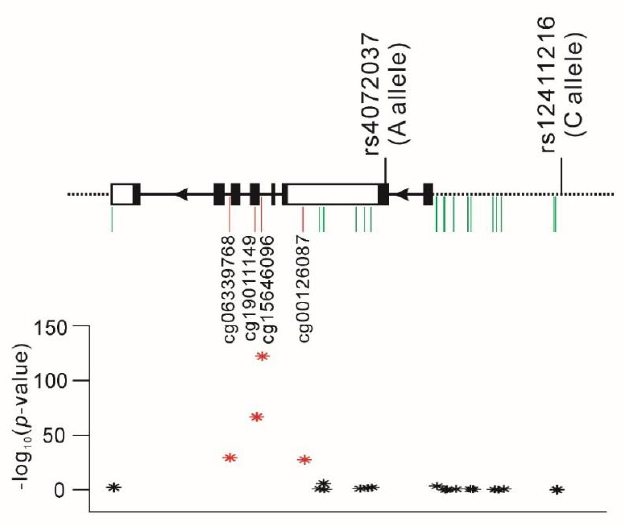
Figure 2. Genomic structure of functional MUC1 variants and their association with MUC1 gene DNA methylation. Regional plot analysis of association between the A allele of rs4072037 and the C allele of rs12411216 and DNA methylation. *: p < 5.00 × 10 − 8 , *: p ≧ 5.00 × 10 − 8 . The C allele of rs12411216 and the A allele of rs4072037 were significantly associated with the hypermethylated status of the MUC1 gene body (Figure 3A – H and Table S6).